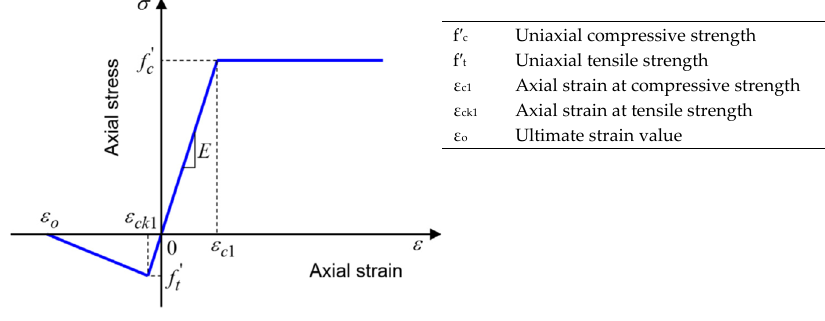
Figure 8. Winfrith Concrete Model.